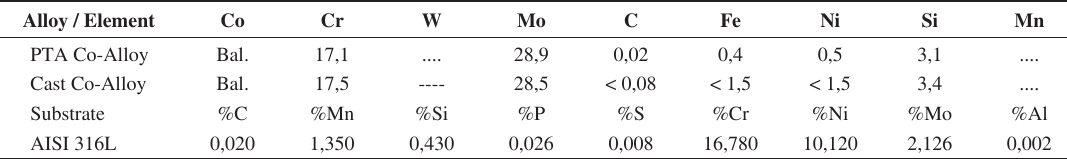
Table 1. Chemical Composition (wt%).